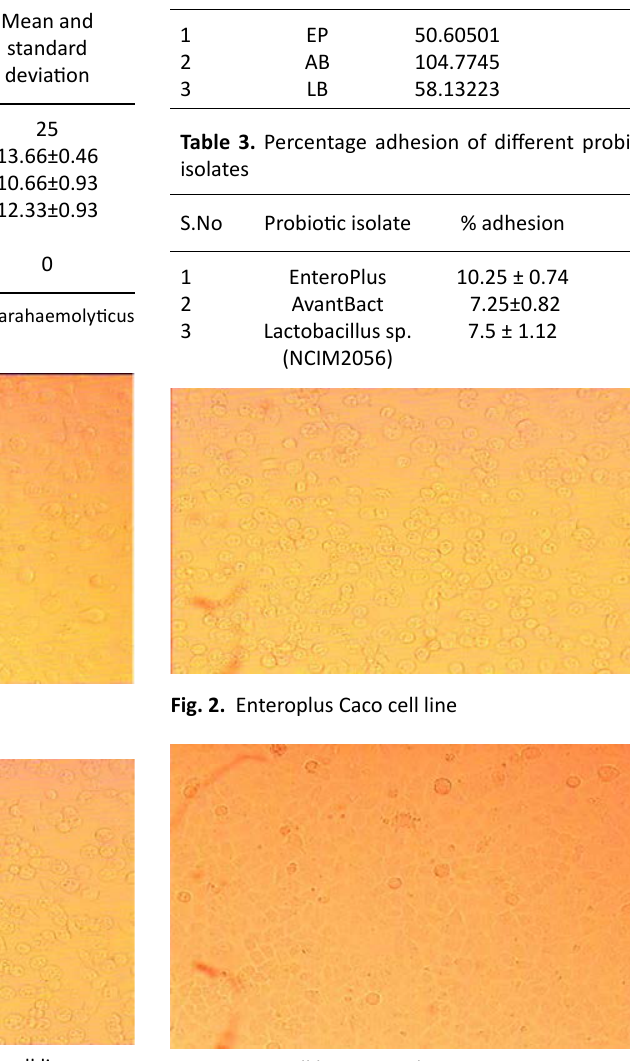
Fig. 3. Lactobaciilu sp(NCIM2056) Caco cell line Fig. 4. Caco cell